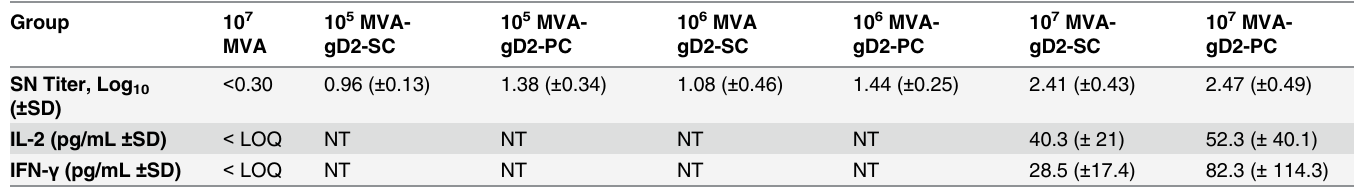
Table 2. Neutralizing antibody titers and cytokine responses following subcutaneous and percutaneous vaccinations with MVA-gD2. Group SN Titer, Log 10 ( ±